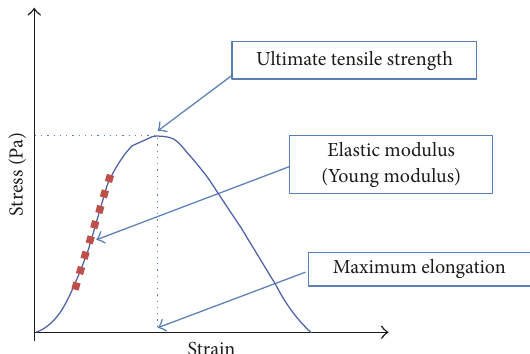
Figure2:Stress-strainexamplecurvewithelasticmodulus,ultimate tensile strength, and maximum